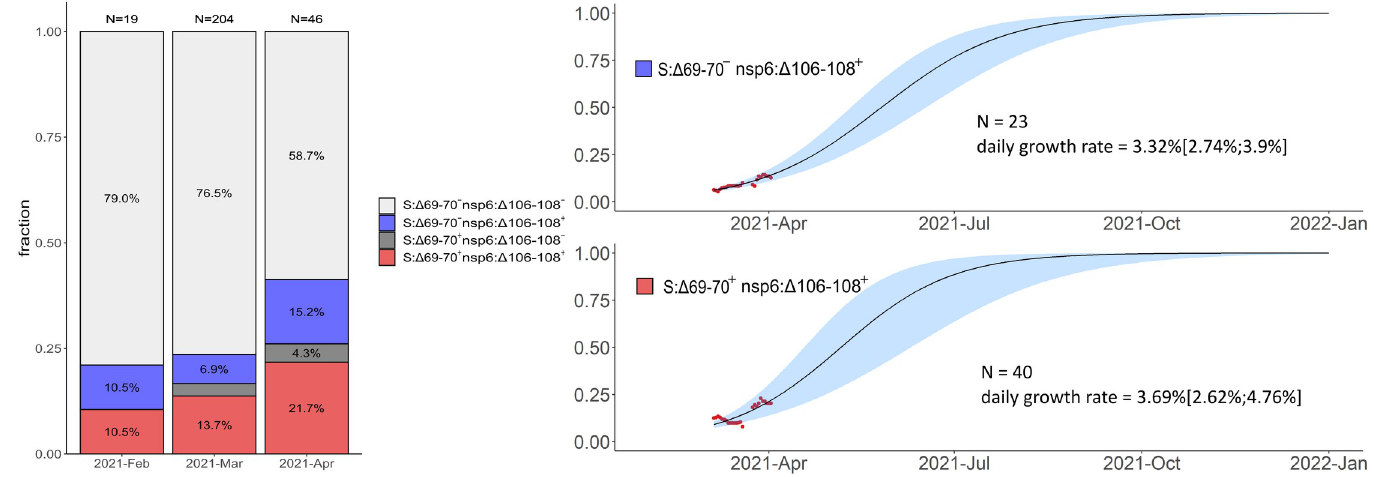
Fig 9. Frequencies of S: Δ 69–70, nsp6: Δ 106–108, and their combination in Russia in Feb-Apr 2021 based on PCR data. S: Δ 69–70 + nsp6: Δ 106–108 + samples correspond to B.1.1.7, and S: Δ 69-70 - nsp6: Δ 106–108 + samples correspond to B.1.1.524 or B.1.1.525. The rare instances of S: Δ 69–70 + nsp6: Δ 106-108 - probably correspond to false positive S: Δ 69–70 detection. Notations for logistic curves are the same as in Fig 6.